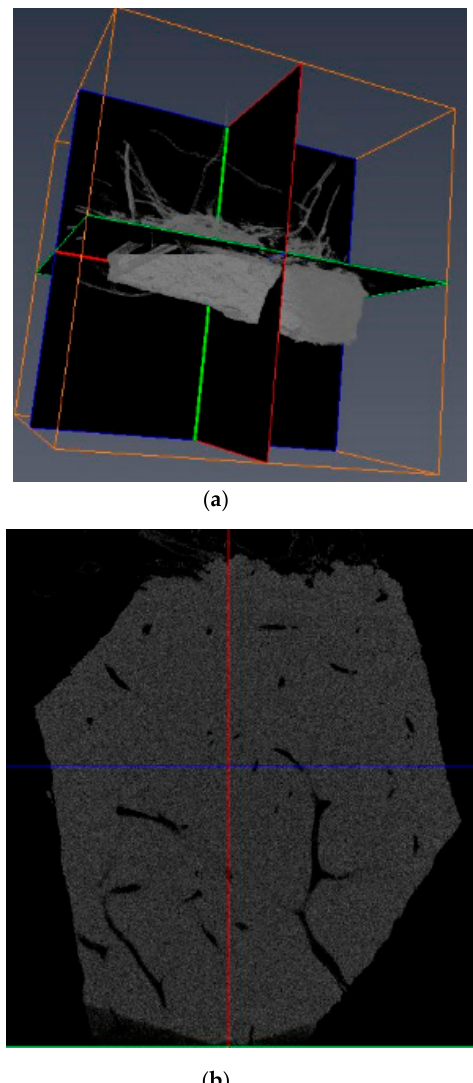
Figure 4. Computed tomography and a coconut shell specimen. ( a ) Perspective view; ( b ) A horizontal cross-section.